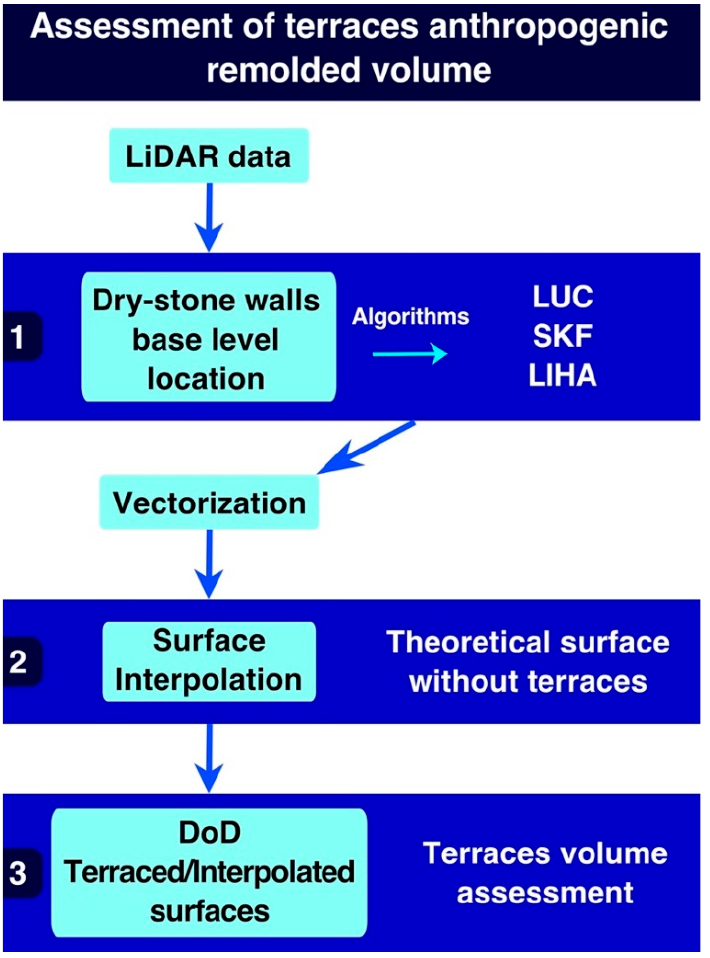
Figure 3. The methodological workflow: 1. Localization of stone-wall basis through the application of three algorithms; 2. The theoretical surface without terraces is obtained through the basis interpolation; 3. Terrace volume is obtained through DoD between the terraced surface and the interpolated one.